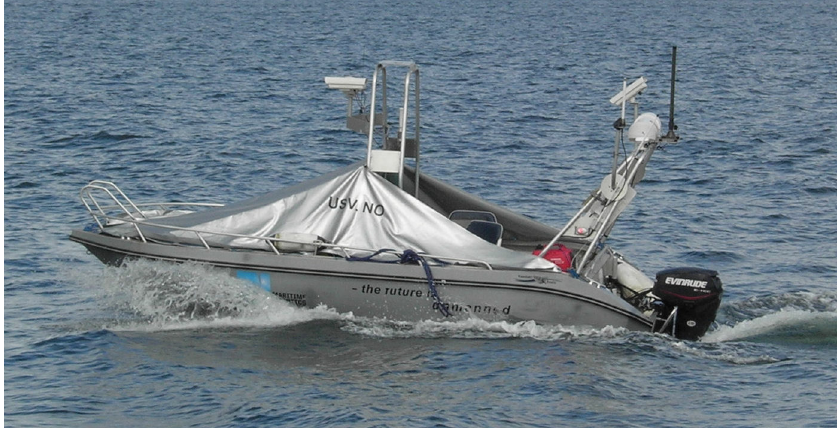
Figure 6: The Kaasbøll USV operating in the